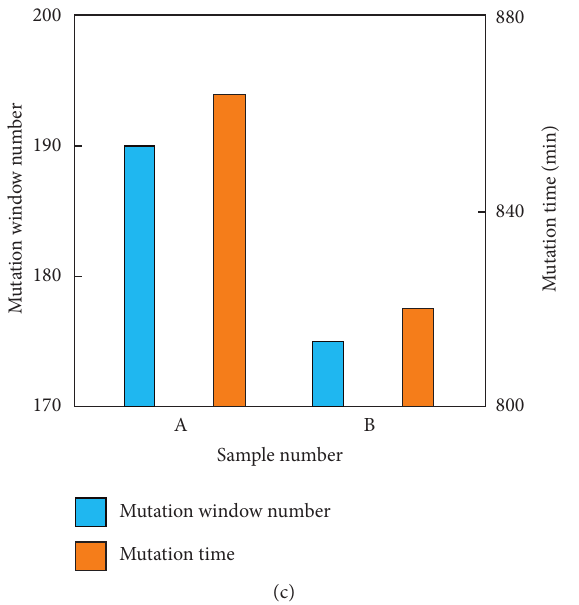
Figure 10: Mutation detection results of ore samples: (a) approximate entropy curves of sample A; (b) approximate entropy curves of sample B; (c) mutation Table 2: Comparisons of the reference and measured values of self-heating initiative temperature. Sample number